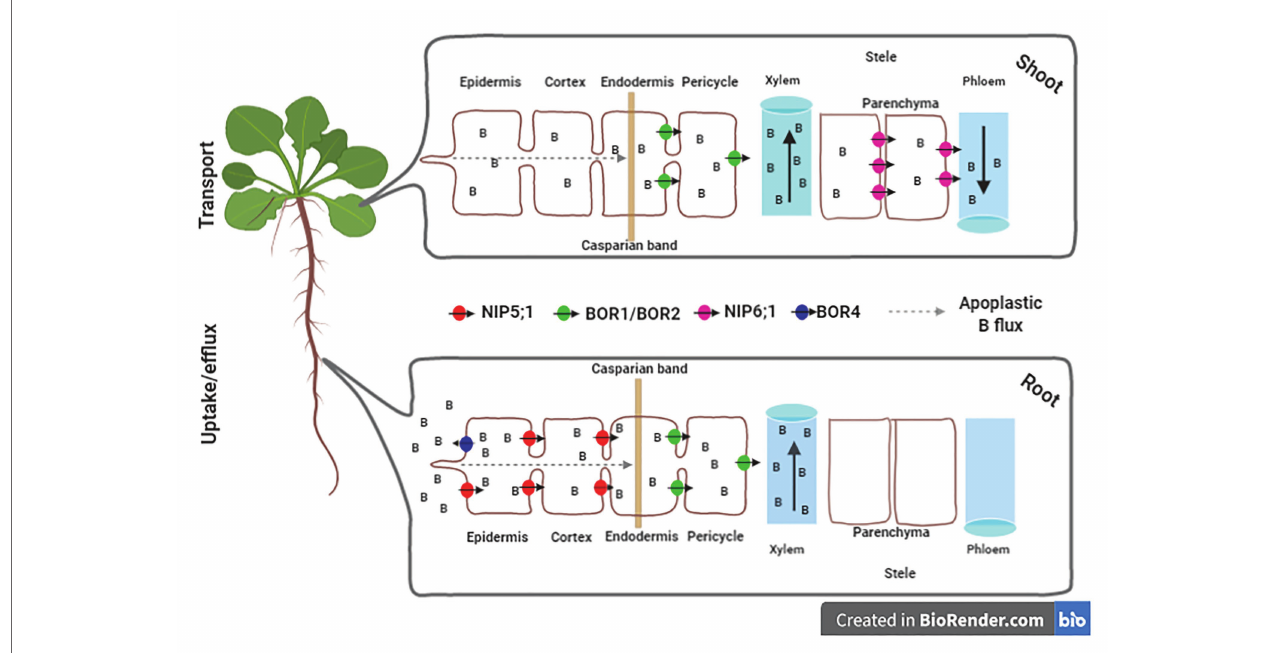
FIGURE 1 | Overview of homeostasis of the boron (B) levels in plant cell mediated by transports. In Arabidopsis thaliana roots, B homeostasis is mainly based on three transport mechanisms across the plasma membrane. The first is the simple diffusion of boric acid (H 3 BO 3 ), without charge through the lipid bilayers. The second mechanism represents the facilitated diffusion mediated by channels of the aquaporin family, such as NIP5;1. The third refers to the B movement by specific transports (e.g., BOR 1, BOR2, and BOR4). The uptake channels NIP5;1 is expressed in the plasma membranes of root cap and epidermal cells with outside/soil- facing polarity (Takano et al., 2006; Wang et al., 2017). NIP5;1 mediates the efficient radial transport of B from the soil through the epidermis and cortex to the endoderm. The Casparian band developed in the endoderm limits the apoplastic flow of B to the stele. BOR1 and BOR2 are expressed at the endodermis in meristematic and maturation zones (Miwa et al., 2013; Reid, 2014; Yoshinari et al., 2019). BOR1 and BOR2 are polarly localized in the stele-side plasma membrane domain (Takano et al., 2010; Miwa et al., 2013). BOR4 located in the root epidermis aid in the efflux of B from the root to the soil solution (Miwa et al., 2007). In shoots, NIP6;1 is necessary for the transport of B from xylem to phloem in nodal regions, being located in the parenchyma of the stele (Tanaka et al., 2016). Figures were created using the software biorender